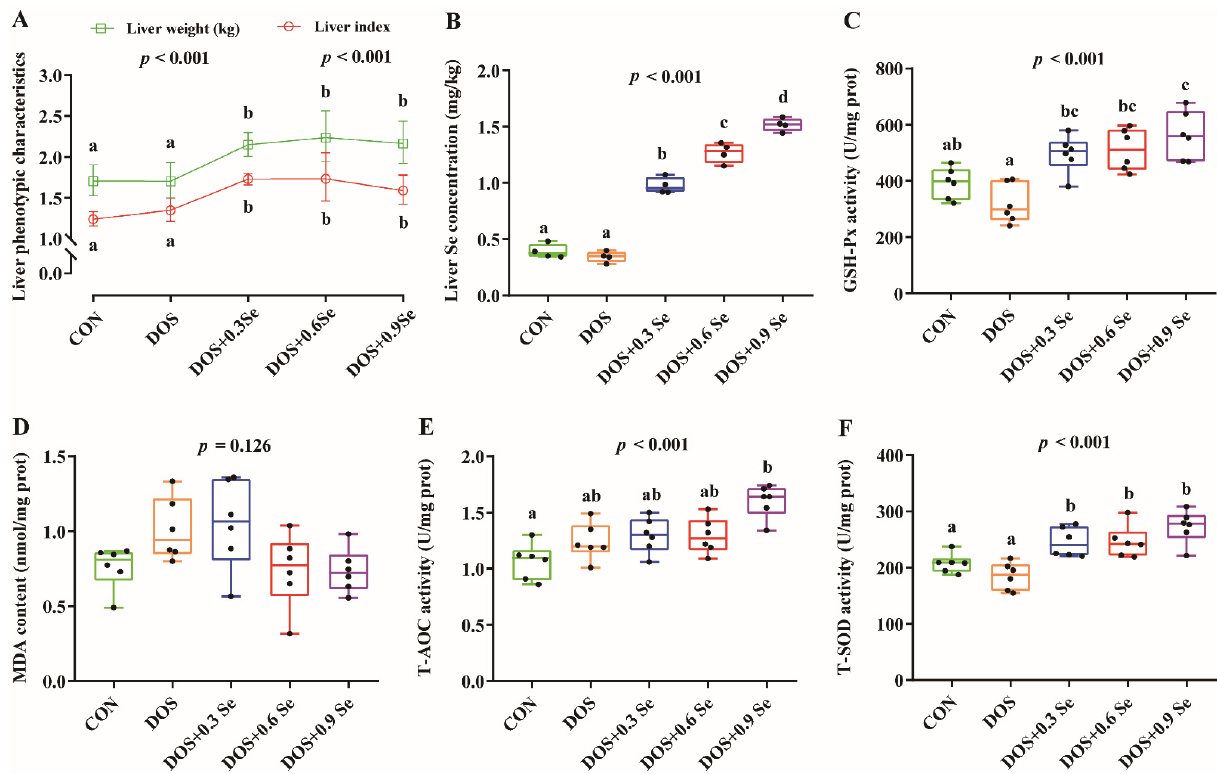
Figure 1. Effects of dietary oxidative stress and OH-SeMet supplementation on liver phenotypic characteristics, Se concentration and antioxidant capacity of growing-finishing pigs. ( A ) Liver phenotypic characteristics; ( B ) Liver Se concentration; ( C ) GSH-Px activity; ( D ) MDA content; ( E ) T-AOC activity; ( F ) T-SOD activity. Results were expressed as mean ± SD ( n = 6 or 4), different letters indicate ANOVA p value less than 0.05 which represent there is a significant difference between groups. Table 1. Effects of dietary oxidative stress and OH-SeMet supplementation on serum biochemical indicators of growing-finishing pigs.